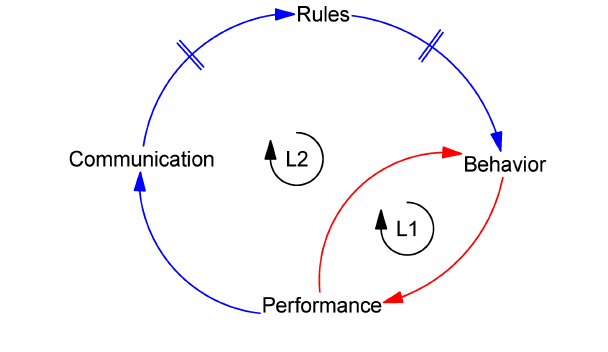
Fig. 12 . Self-governance archetype as a solution to archetypical problem